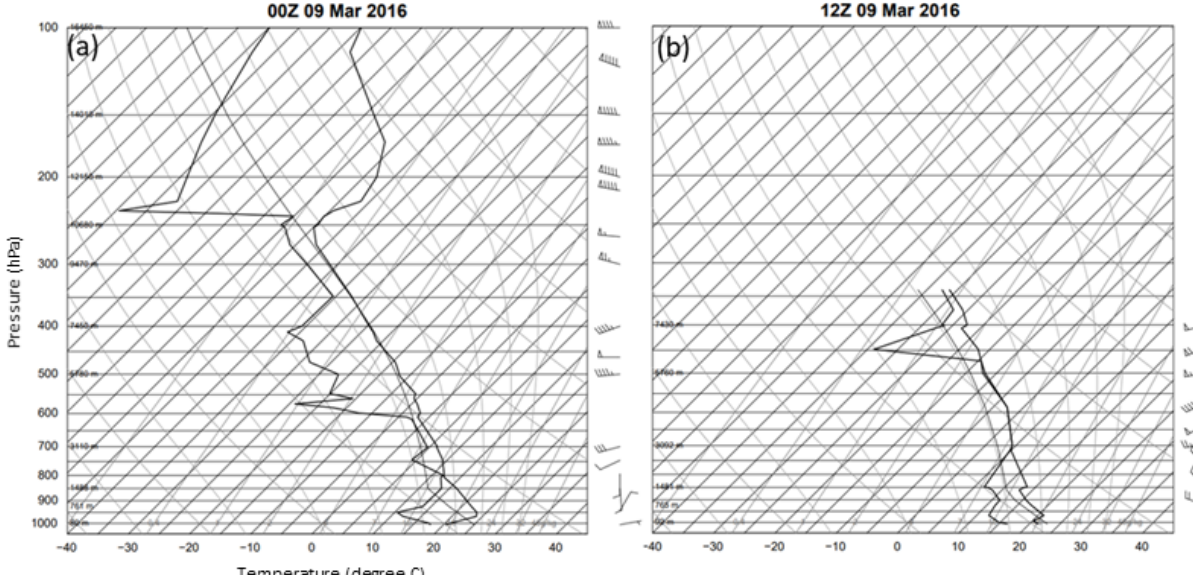
Figure 2. Radiosonde skew-T profiles retrieved at Abu Dhabi Airport on 9 March 2016 at 00:00Z (a) and 12:00Z (b) .